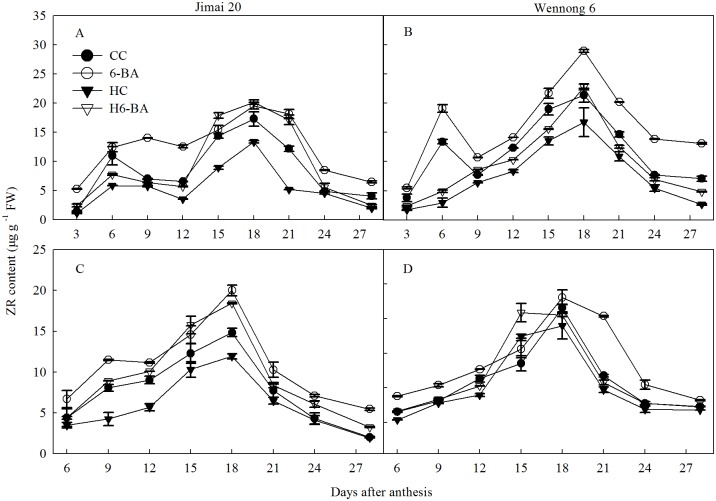
ZR content for superior (A, B) and inferior kernels (C, D).CC and 6-BA represent treatment with water and 6-BA under non-heated condition, respectively. HC and H6-BA represent treatment with water and 6-BA under heated condition, respectively. Vertical bars represent ± standard error of the mean (n = 3) where they exceed the size of the symbol.